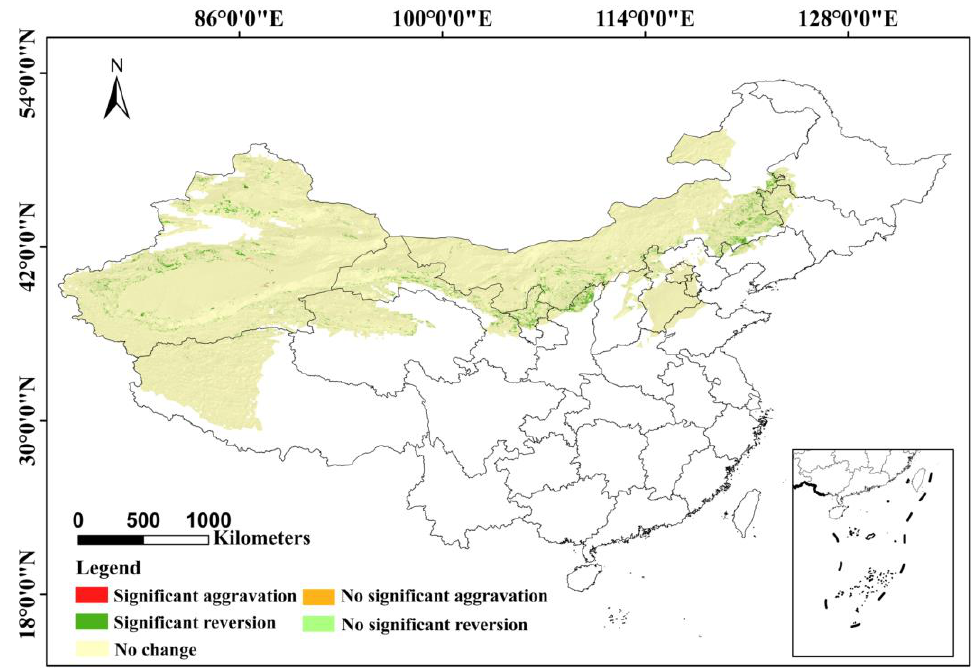
Figure 8. Desertification trends from 2000 – 2020 based on the Theil – Sen Median slope and Mann – Kendall test.